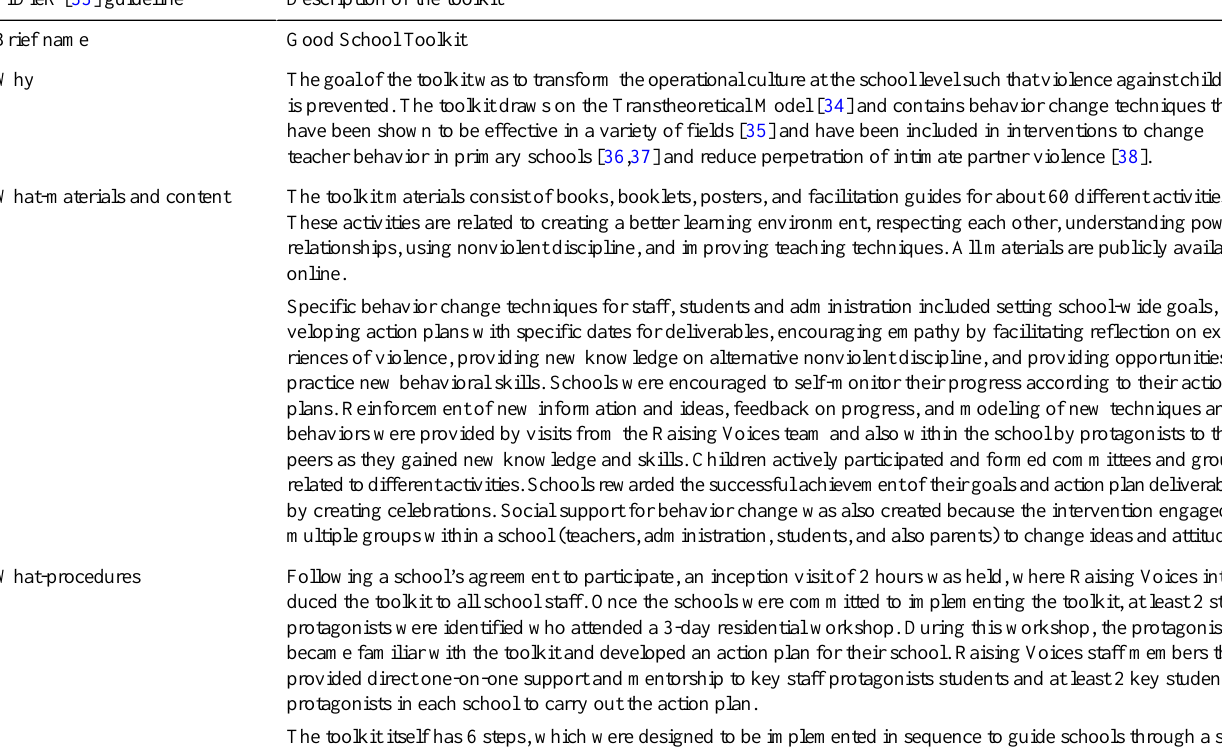
Table 1. The Good School Toolkit intervention delivered during the trial and later delivery to study schools. Description of the toolkitTIDieR [33]